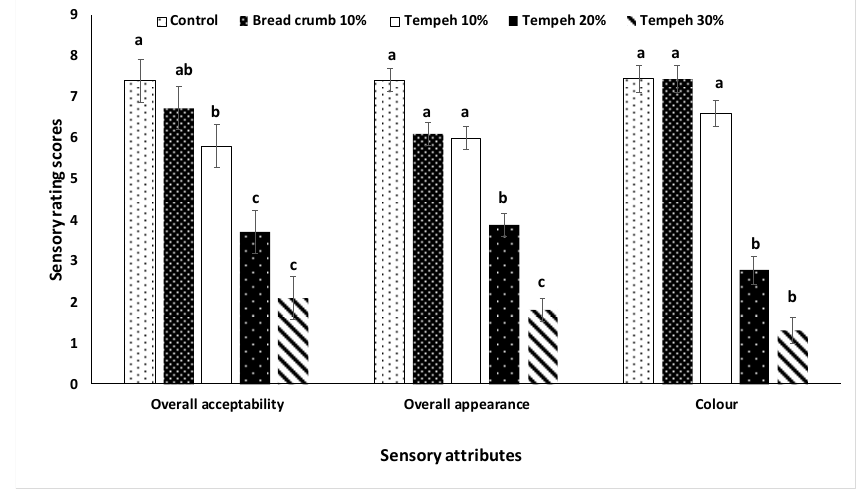
Figure 2. Sensory attribute scores of five raw beef patties substituted by tempeh at di ff erent levels. The patties were evaluated by focus groups ( n = 15). a–c Within each sensory attribute, bars that do not share the same superscripts are significantly di ff erent ( p <